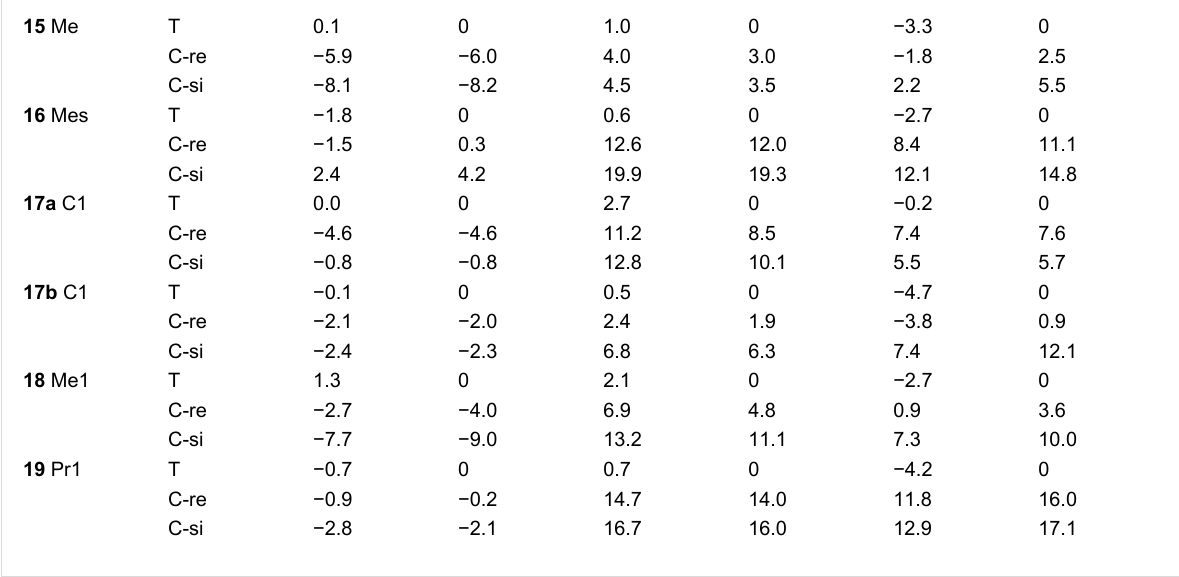
Table 2: Energies ( E) in kcal/mol, of the coordination intermediates, transition states and metallacycles with respect to the 14e species and the unco- ordinated C=C double bond. For each system, the energies of both isomers with the C=C trans or cis to the NHC ligand are reported. For each species, Δ E is the energy difference between the cis and the trans isomer, labeled as C and T, respectively. (continued) 15 Me